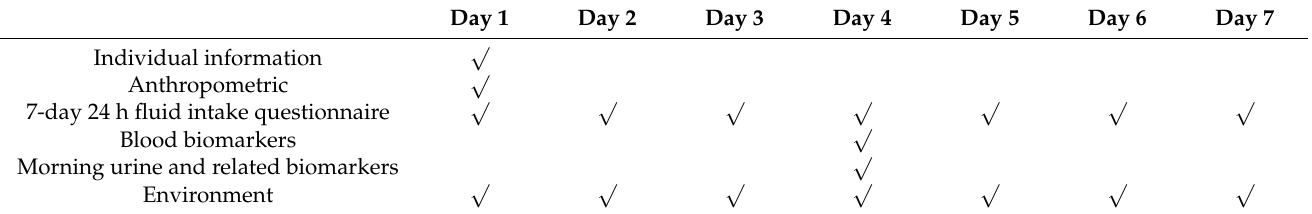
Table 1. The indicators and pregnancy outcomes collected at different time points in this